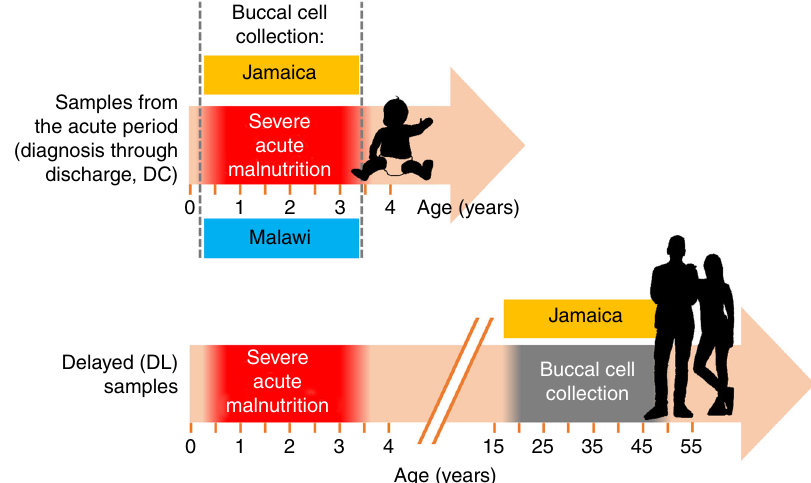
Fig. 1 Overview of sampling timeline across both cohort locations and time